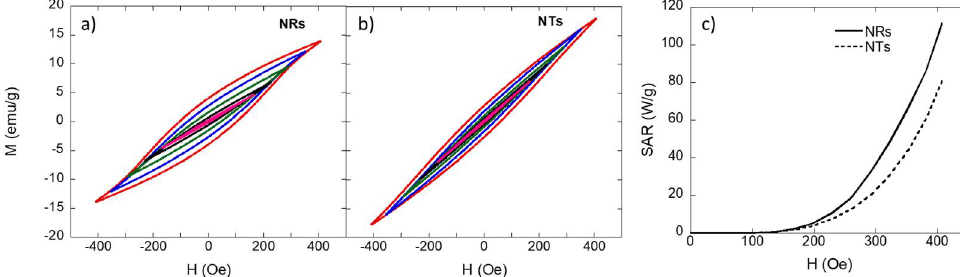
Figure 4. AC magnetometry loops obtained for ( a ) the iron oxide NRs and ( b ) NTs at 300 kHz with H max = 400 Oe. ( c ) SAR vs. H curves derived from the AC hysteresis loop area (H = 0–400 Oe, f = 300 kHz).